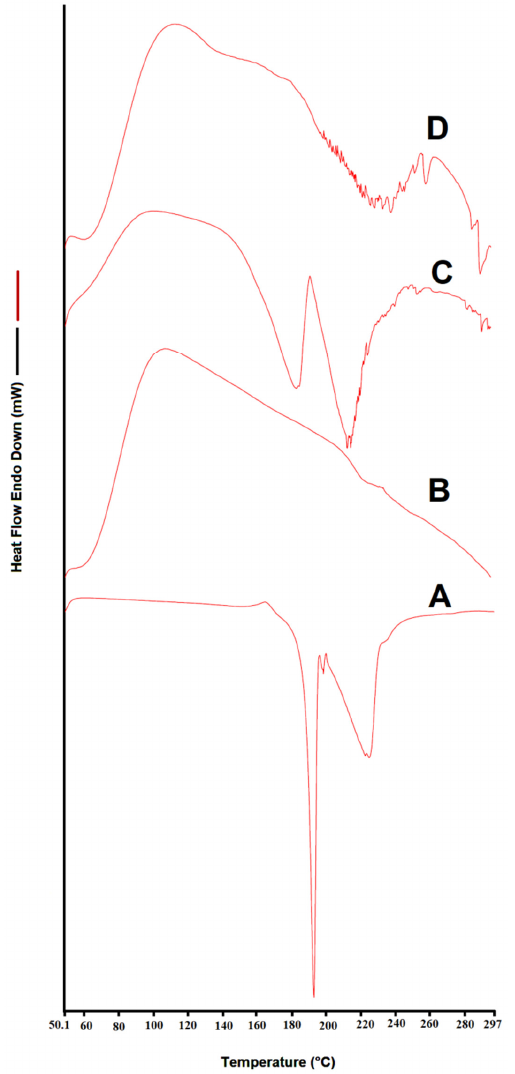
Figure 2. DSC thermogram of ( A ) SA, ( B ) HPβCD, ( C ) BPM, and ( D ) BIC.